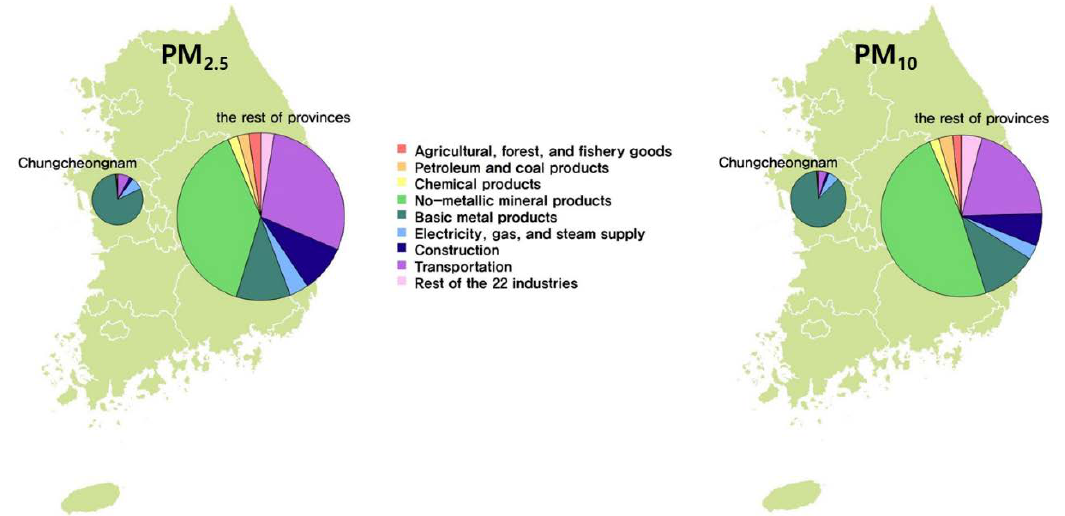
Figure 3. Comparison between Chungcheongnam-do (CN) and the rest of the Korean provinces (RP) for the high-emission industries of PM 2.5 (left) and PM 10 (right) in 2014 (note: circle size indicates the relative total amount of power generation when the value of CN is equivalent to 1).